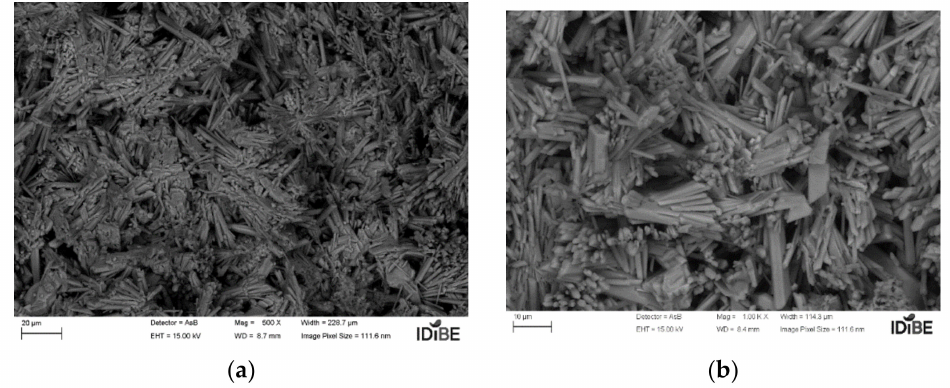
Figure 9. Additive plaster 1—Y2 micrograph: ( a ) 20 µ m; ( b ) 10 µ m (source: the author).